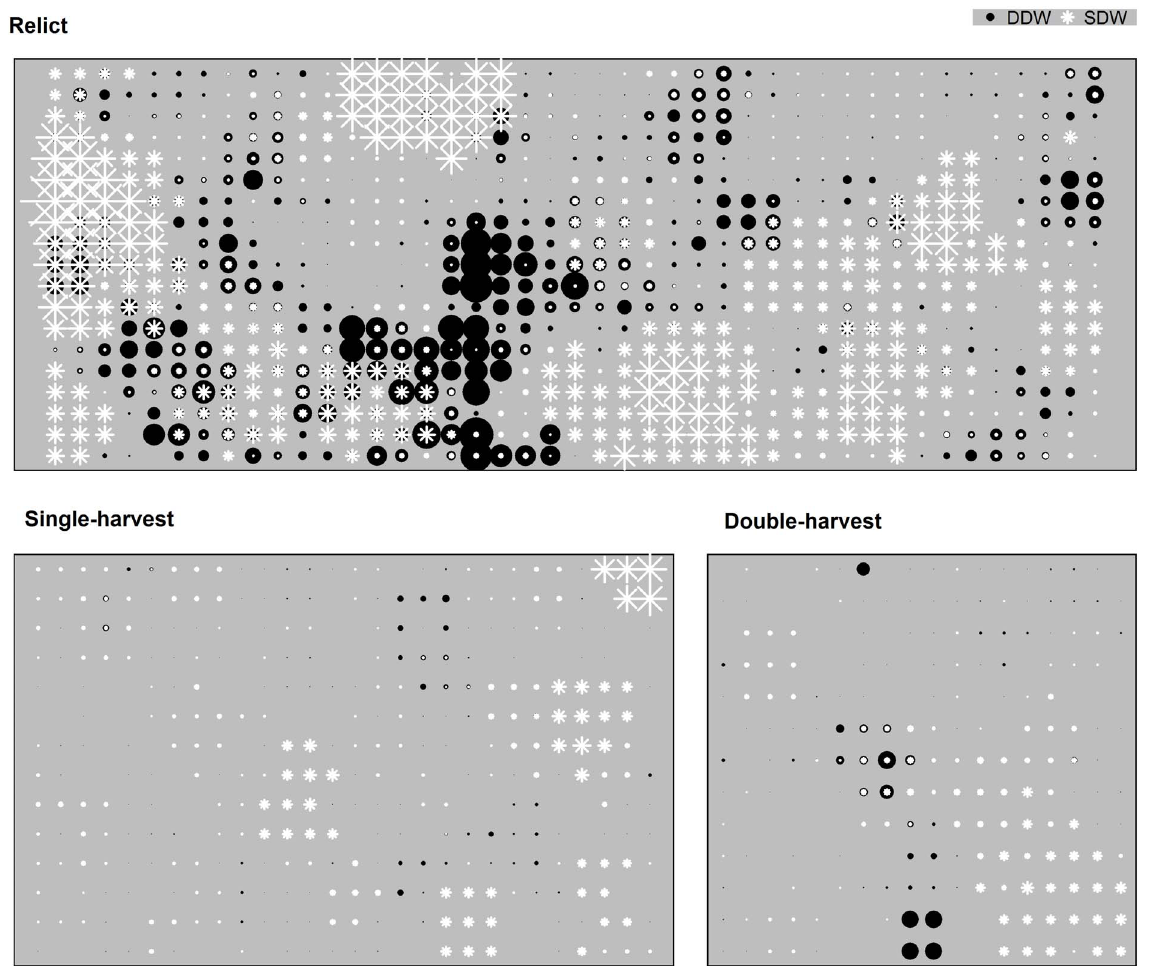
Figure 6. Coarse woody debris spatial distributions by volume. Each panel displays the volume (m 3 ) of downed deadwood (DDW; black circles) and standing deadwood (SDW; white stars) sampled at each plot location for relict, single-harvest, and double-harvests stands; size of symbol within each pane is standardized.